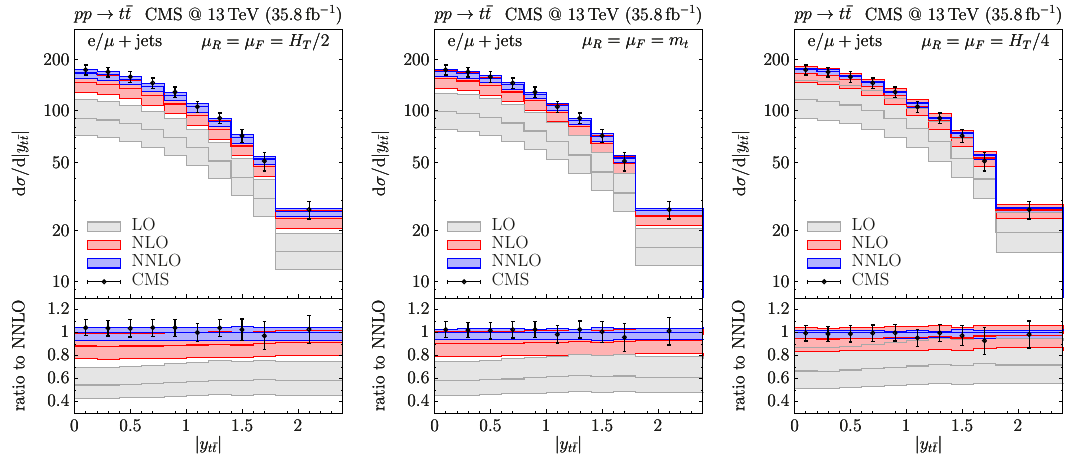
Figure 5 . Single-di(cid:11)erential cross sections as a function of y t (cid:22) t . CMS data [9] and LO, NLO and NNLO results for central scales equal to H T = 2 (left), m t (central) and H T = 4 (right). di(cid:11)erential observables were presented in ref. [42]. In the case of the p T;t distribution, the had EW corrections are negative and lead to percent-level e(cid:11)ects at low transverse momenta, which increase up to about 5% in the highest- p T bins in (cid:12)gure 3. Such e(cid:11)ects are of the (cid:0) order of (or smaller than) the residual perturbative uncertainties of the NNLO result,